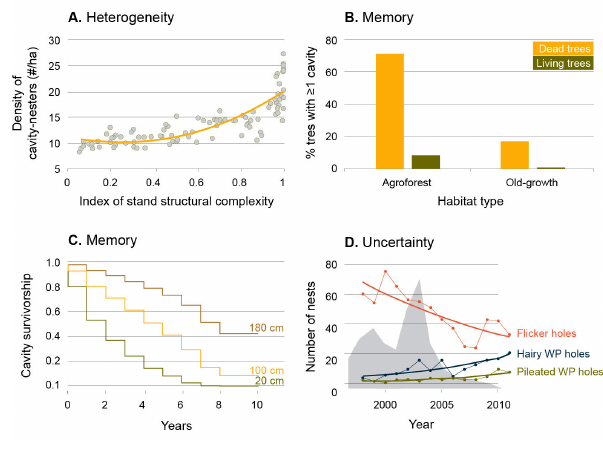
Fig. 5 . Properties of nest webs for different study systems in the Americas. (A) Heterogeneity (Chile): stands with a dense understory, large-decaying trees, and a deep leaf-litter create microhabitats (structural complexity) not only for cavity nesters, but also for insects and small mammals, the main food items for several cavity nesters (Caviedes and Ibarra 2017; J. T. Ibarra, unpublished data ). (B) Memory (Ecuador): agroforests sustain habitat legacies (standing dead trees) that are highly used by excavators. They have a disproportionate impact on cavity-nesting community composition (Y. Van der Hoek, unpublished data ). (C) Memory (Argentina): tree-cavity persistence increases with tree size, so that large old-growth trees have a longer legacy (Cockle et al. 2017). (D) Uncertainty (Canada): woodpecker (WP) populations increased during and after an insect outbreak (grey area). Nonexcavators switched from Northern Flicker ( Colaptes auratus ) cavities to cavities created by a broader suite of woodpeckers, leading to changes in nest web architecture, including increased evenness (Cockle and Martin